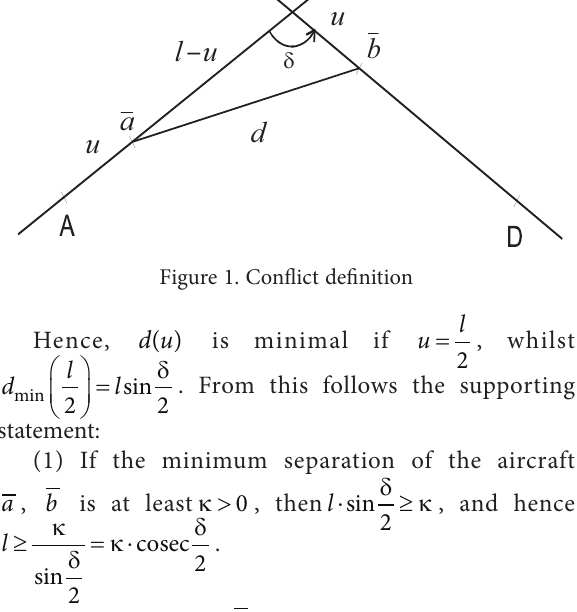
Figure 1. Conflict